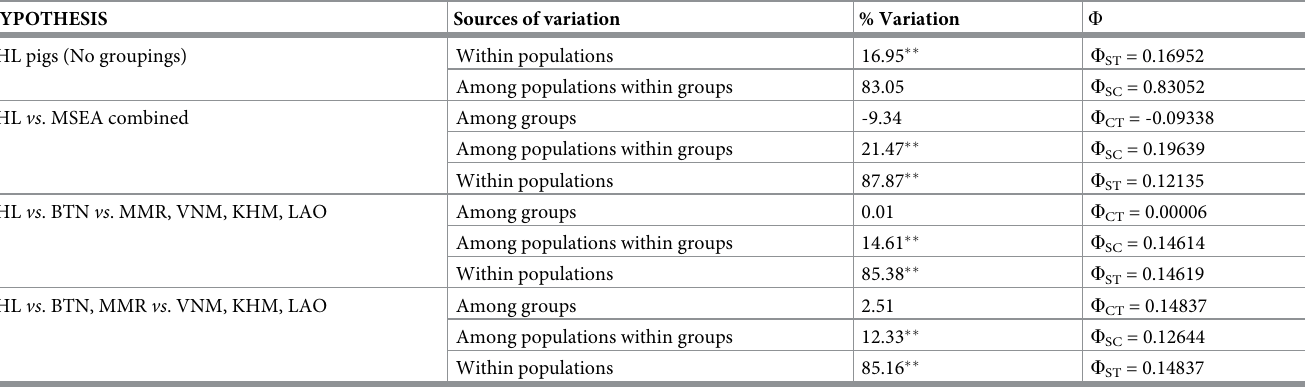
Table 2. Analysis of molecular variance (AMOVA) of Philippine domestic pigs and mainland Southeast Asian pigs.